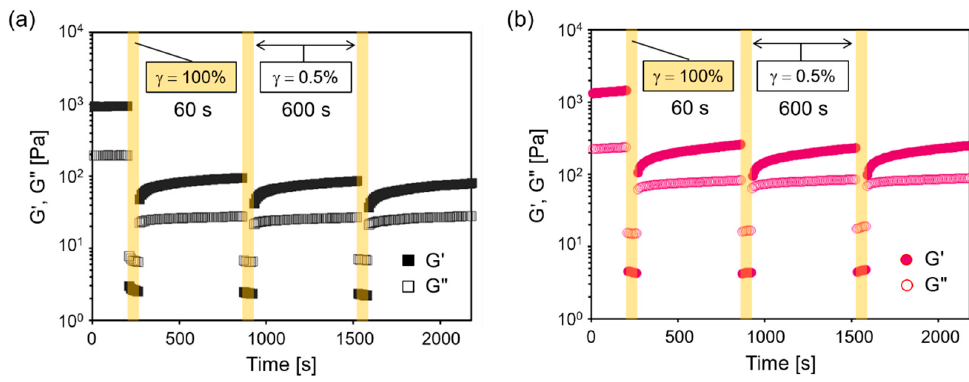
Figure 5. Changes of G’ and G” in step-strain sweep dynamic rheological measurements (1 Hz). ( a ) 0.5 wt% GPG1, 1 d, ( b ) 0.5 wt% GPG3, 7